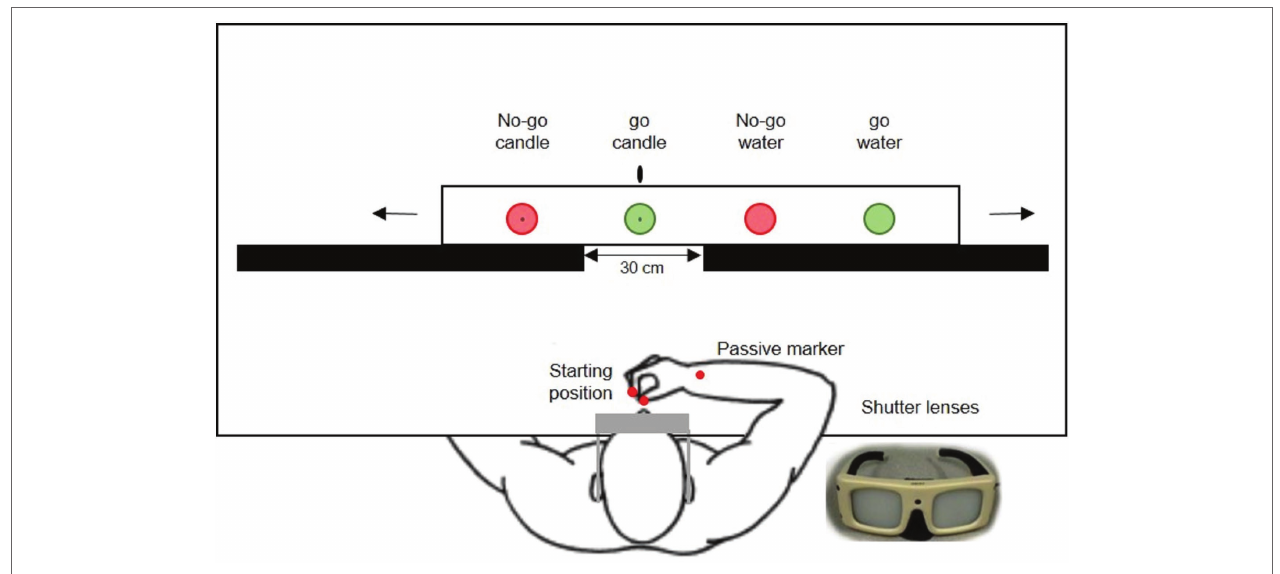
FIGURE 1 | Drawing of the experimental set-up. The subject wears shutter goggles which become transparent to indicate trial onset, allowing the subject to reach and grasp green glasses. Red glasses are used for no-go trials. One glass of each color is filled with water, whereas the other one is filled with transparent gel wax and includes a central